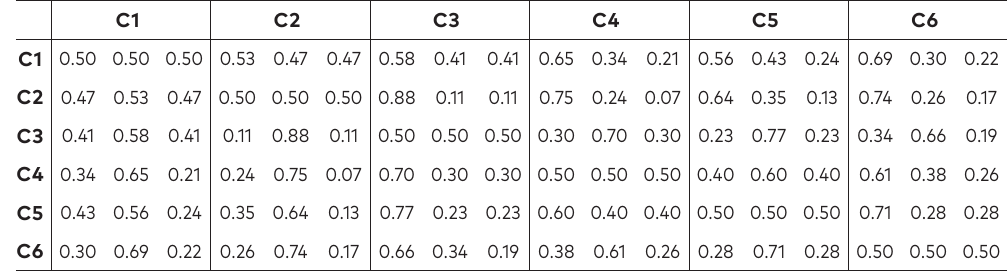
Table 8. The fused preference relation